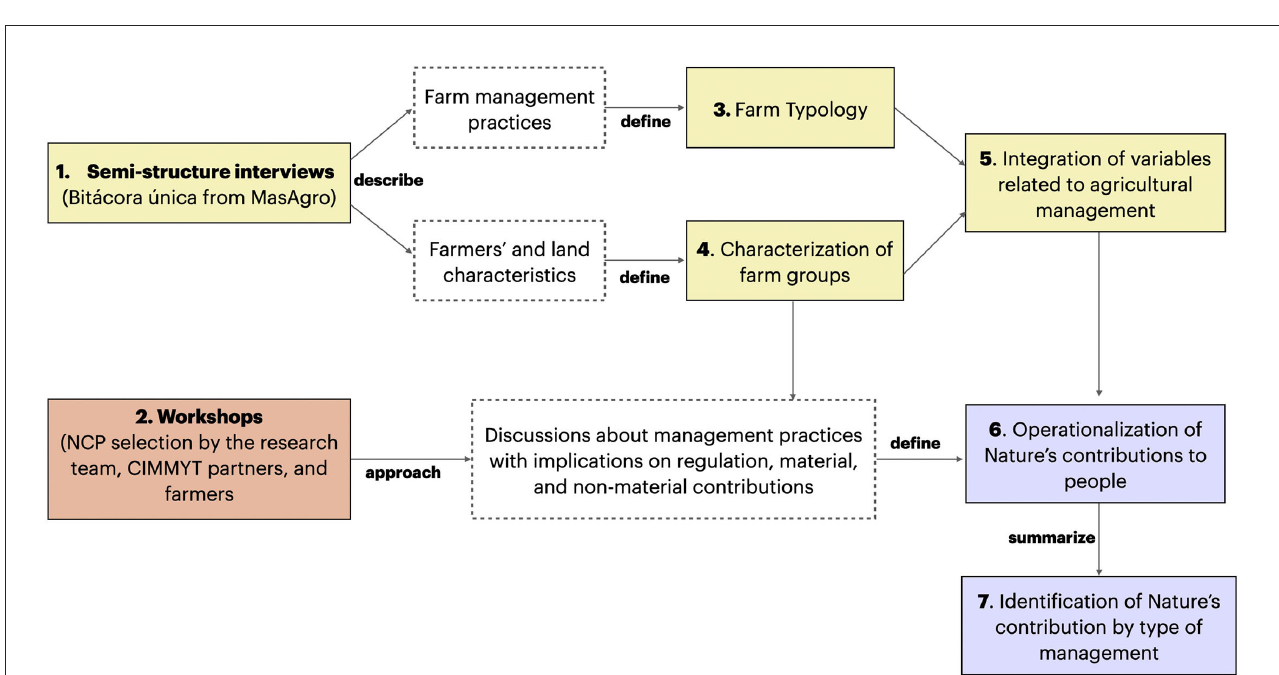
FIGURE2 General methodology in this study. The data sources are marked with numbers 1 and 2, the boxes with solid lines and numbers indicate methodological steps, and the numbers indicate the order of the methodology. The boxes with dotted lines indicate elements of interest in each step.